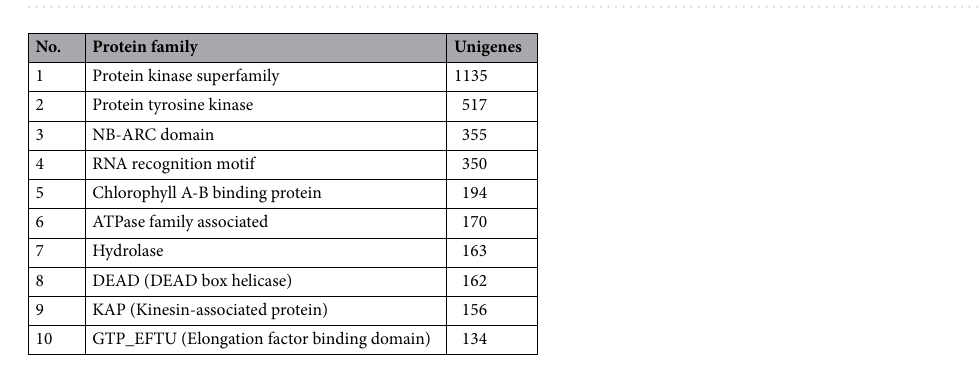
Figure 5. Gene ontology classifications. The results are summarized according to the three main categories: biological process, cellular component, and molecular function. The GO terms assigned to faba bean transcripts with matches in the UniProt database revealed by a BLAST search are presented.